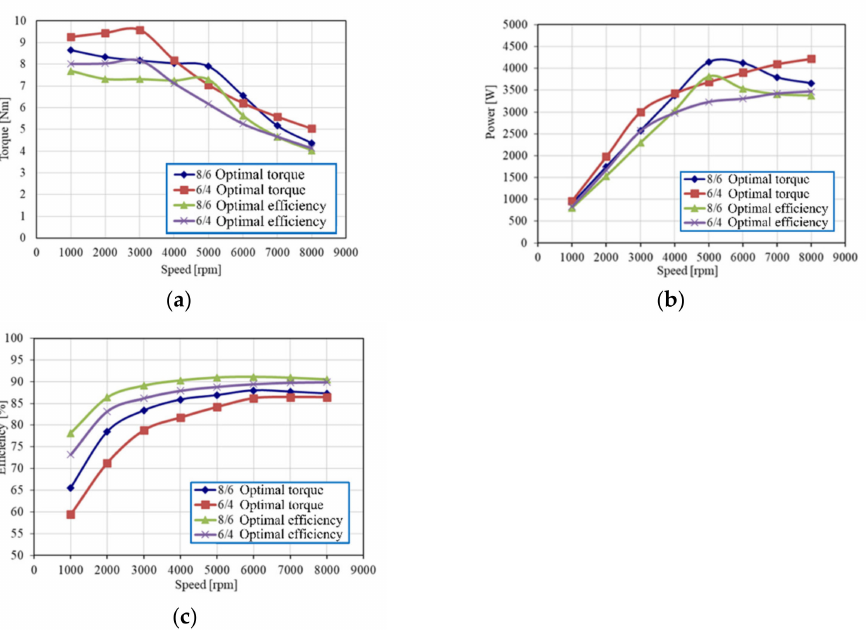
Figure 4. The simulated performance of the designed four-phase 8/6 and three-phase 6/4 SRM under optimal torque and optimal efficiency operations: ( a ) average torque versus rotating speed; ( b ) power versus rotating speed; ( c ) efficiency versus rotating